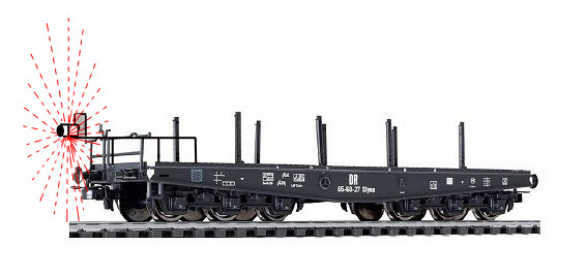
Figure 1. Schematic diagram of flatcar with a single profiling scanner